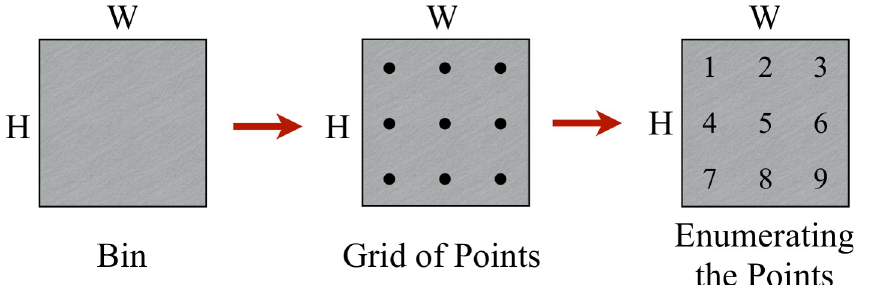
Fig 3. Grid inside of the bin. First step of the P&C methodology.